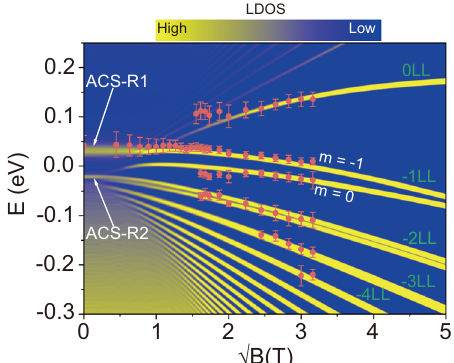
Fig. 4 Evolution from the ACSs to unusual LLs in the GQD. The measured LLs at the center of the GQD ( β = 2.4, r 0 = 9 nm) as a function of the ffiffiffi p B square root of the magnetic fi eld . The experimental results are superimposed onto the calculated map of LDOS in the GQD with β = 2.4 and r 0 = 9 nm. The ACS-R1 and ACS-R2 are two quasi-bound states due to atomic collapse resonance. The full width at half maximum of the peaks in the spectra was used to estimate the error bar in experiment (orange